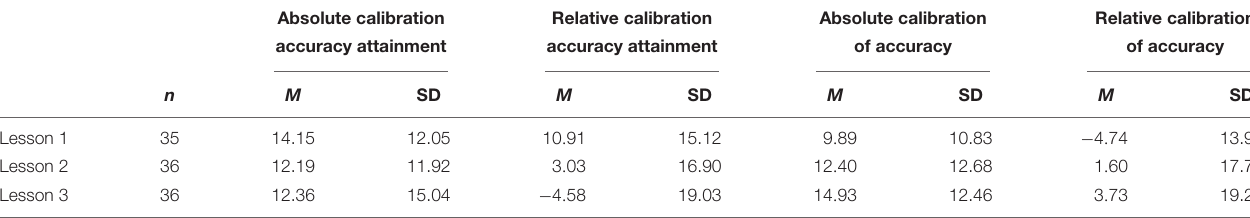
TABLE 8 | Correctness of the signals : overview of absolute and relative calibration of accuracy attainment and accuracy per lesson. Absolute calibration Relative calibration Absolute calibration Relative calibration accuracy attainment accuracy attainment of accuracy of